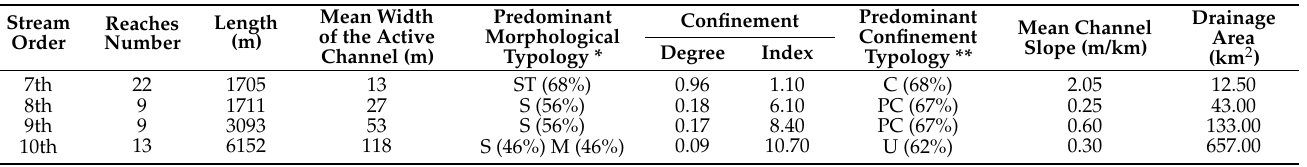
Table 6. Median value of the main numeric parameters (2nd quartile) and predominant river morphology and confinement typology for reaches (of the same order) obtained during the segmentation phase of MQI in the Dittaino River. Stream Order